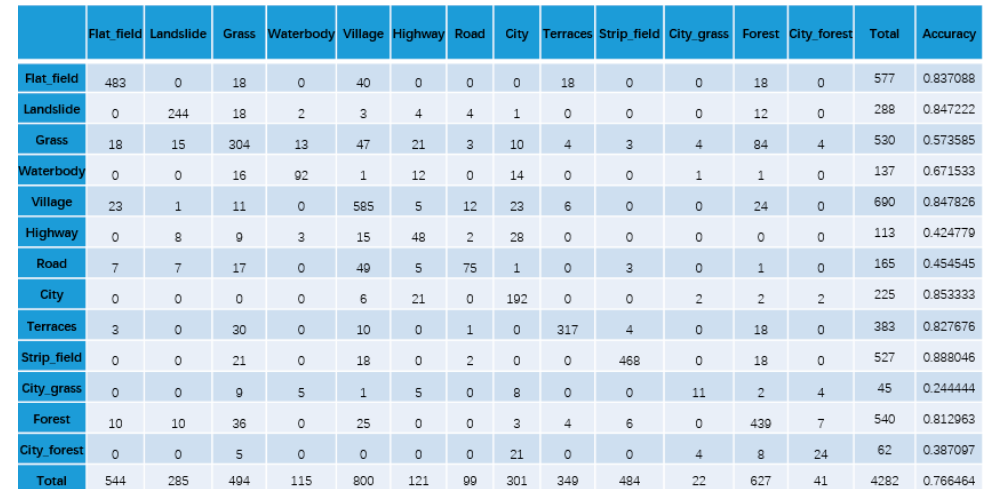
Figure 20. The object-based confusion matrix of the KGGCN model. Additionally, we further compare the three networks in other classification metrics,